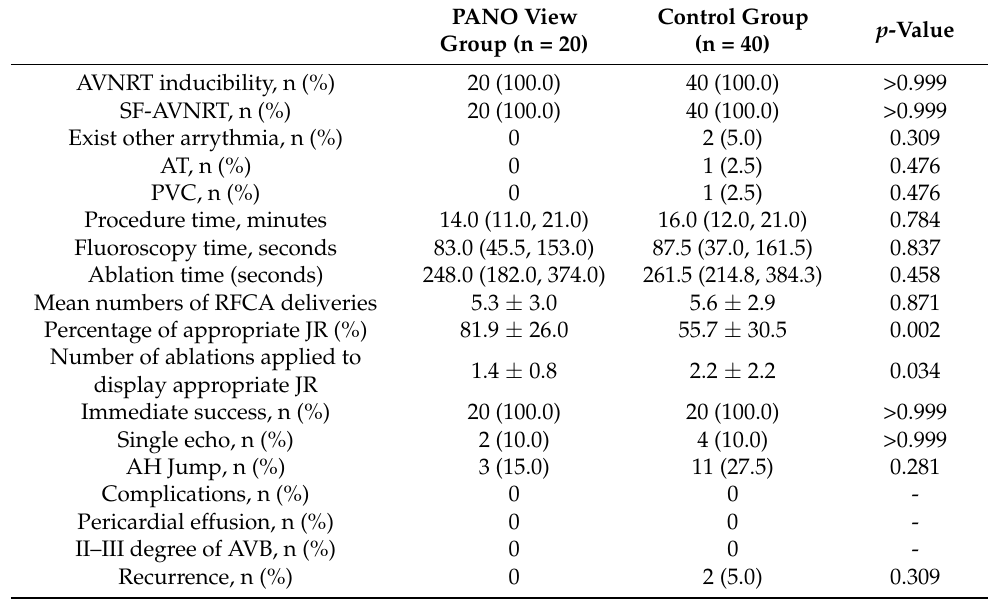
Table 2. Procedure data and outcomes between two